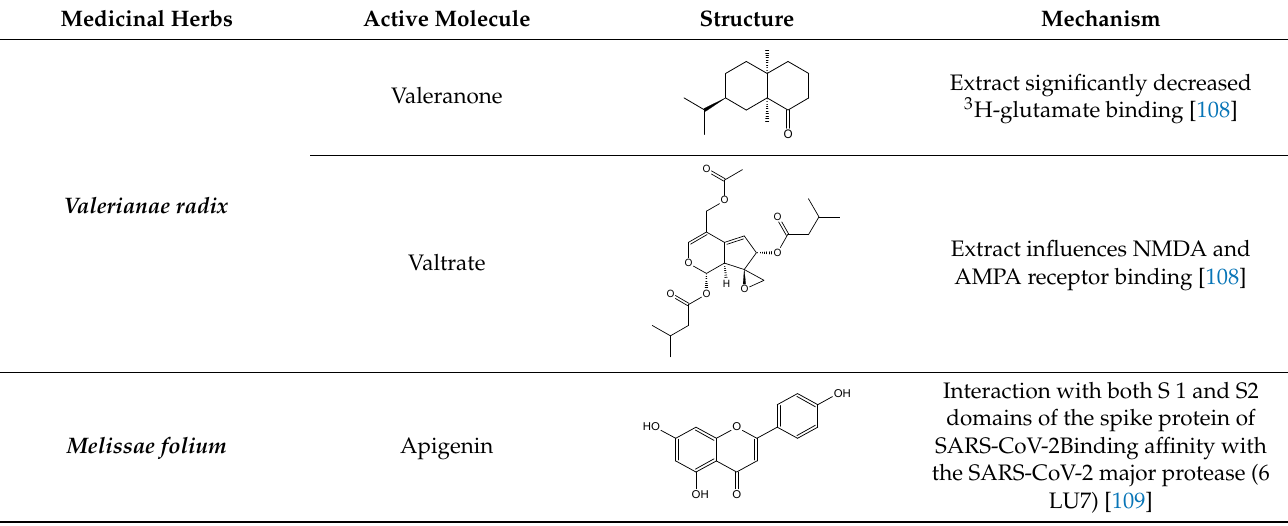
Table 1. Chemical structure of main chemical compounds in medicinal herbs for the relief of neurological, cardiovascular, and respiratory symptoms after COVID-19 infections.